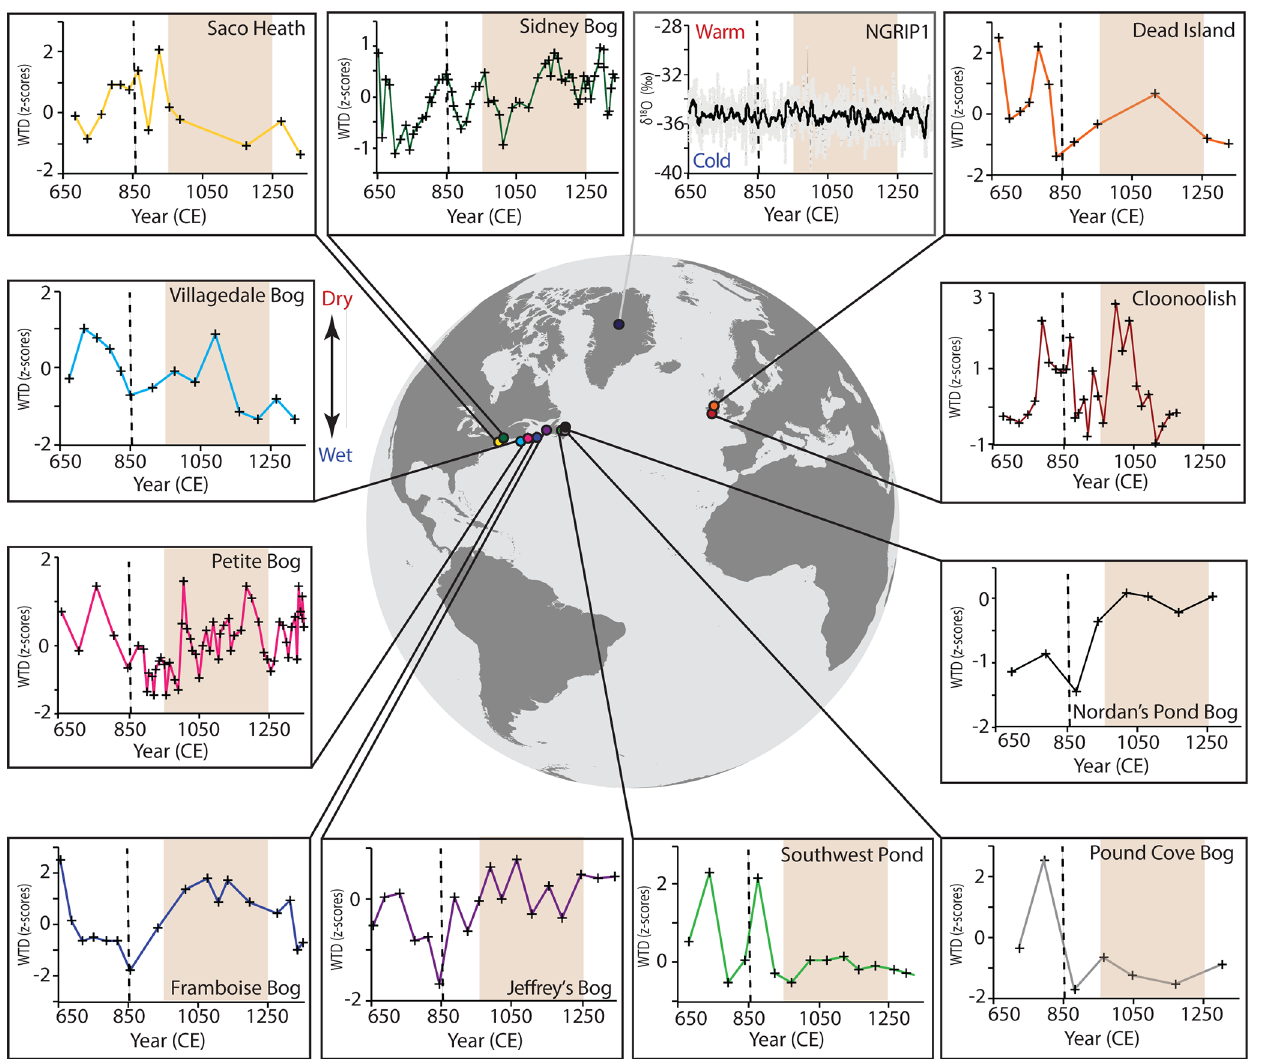
Figure 6. Available moisture reconstructions from terrestrial and glacial archives containing the WRAe from the North Atlantic region. Records have been developed using δ 18 O isotopes from NGRIP1 (Vinther et al., 2006), where the black line represents decadal-scale moving average and data are plotted on NS1-2011 chronology (Sigl et al., 2015; for detailed 9th-century NGRIP1 δ 18 O isotopes see Appendix I), and peatland water table depths inferred from testate amoebae. Dashed vertical line represents the WRAe and the pink shaded box represents the MCA time period based on the Mann et al. (2009) timings (950–1250CE). Sites have been arranged clockwise with Irish records (Dead Island and Cloonoolish) located on the top right of the diagram followed by North American sites from northeast to southwest with records from Newfoundland (Nordan’s Pond bog, Pound Cove bog, Southwest Pond and Jeffrey’s Bog), Nova Scotia (Framboise Bog, Petite Bog, Villagedale Bog) and Maine (Saco Heath and Sidney Bog) and finally the Greenland NGRIP1 record (top of the